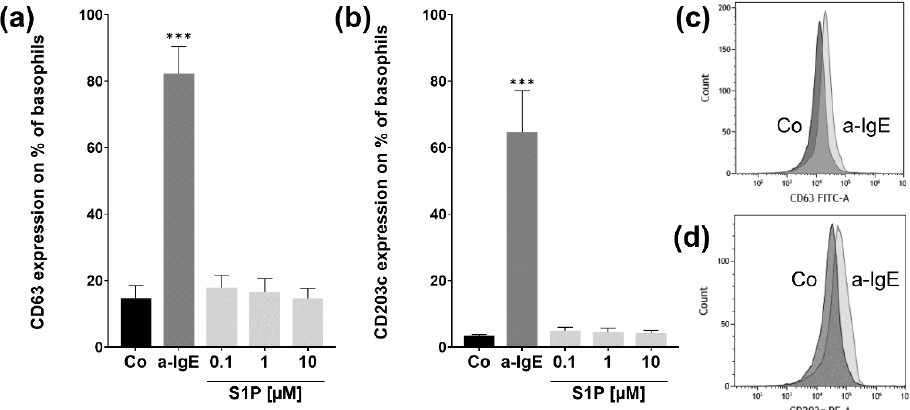
Figure 2. Basophil activation test assay. Flow cytometry analysis of CD63 & CD203c protein expres- sions after stimulation with S1P. Basophils were stimulated with fatty acid free BSA (4 mg/mL) (Co), S1P (0.1 µM, 1 µM, 10 µM) or a-IgE (1 µg/mL) for 30 min ( n = 5). ( a ) CD63 protein expression is significantly increased for the positive control a-IgE. ( b ) CD203c expression is markedly higher in a-IgE than in Co-stimulated cells. ( c ) Representative overlay histogram of CD63 expression in Co (dark grey) and a-IgE stimulated (light grey) basophils. ( d ) Representative overlay histogram of CD203c expression in Co (dark grey) and a-IgE stimulated (light grey) basophils. Data are shown as mean + SEM, p -values (*** ≤ 0.001). Significances are calculated in relation to the Co group.